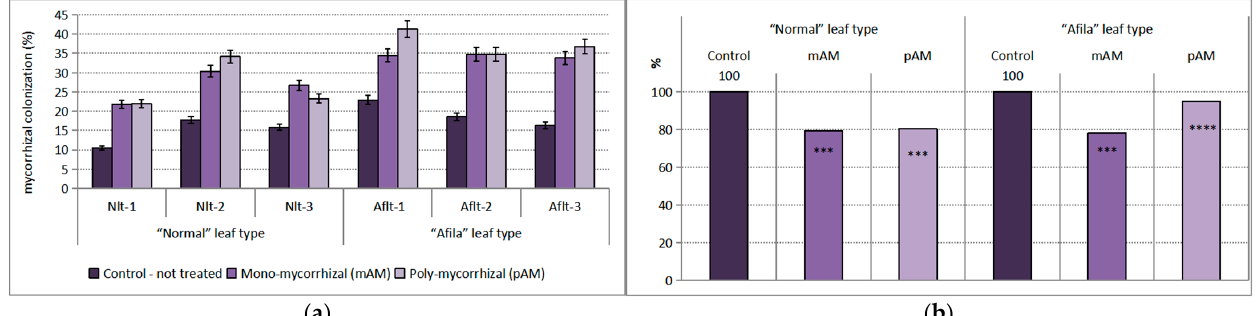
Figure 8. Degree of mycorrhizal colonization (%) of garden pea genotypes roots. ( a ) Average values for the particular varieties of garden pea with “normal” leaf type (Nlt-1—cvr. Marsi, Nlt-2—cvr. Plovdiv and Nlt-3—cvr. 22/16-n) and “afila” leaf type (Aflt-1—cvr. 22/16-af, Aflt-2—cvr. Kazino and Aflt-3—cvr. Echo). Error bars indicate standard error of the mean (SE). ( b ) Relative values of the differences in the percent of colonization (%) compared to the untreated controls, including means for both “normal” leaf type and “afila” leaf type genotypes. The significance of the differences between means of controls and treatments were calculated with the two-tailed Student’s t -test (at df—10; **** p < 0.001 and *** p <